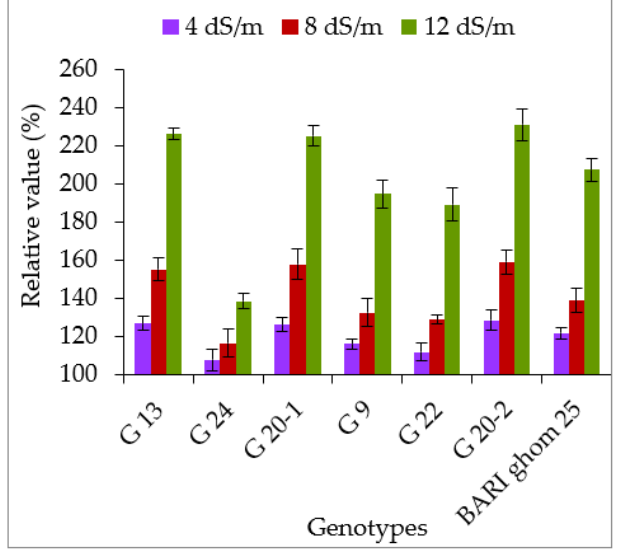
Figure 14. Relative value of soluble sugar content in leaf of wheat genotypes under various salinity levels. The vertical bar indicates average data of five independent replicates ( n = 5). Error bars represent standard error.